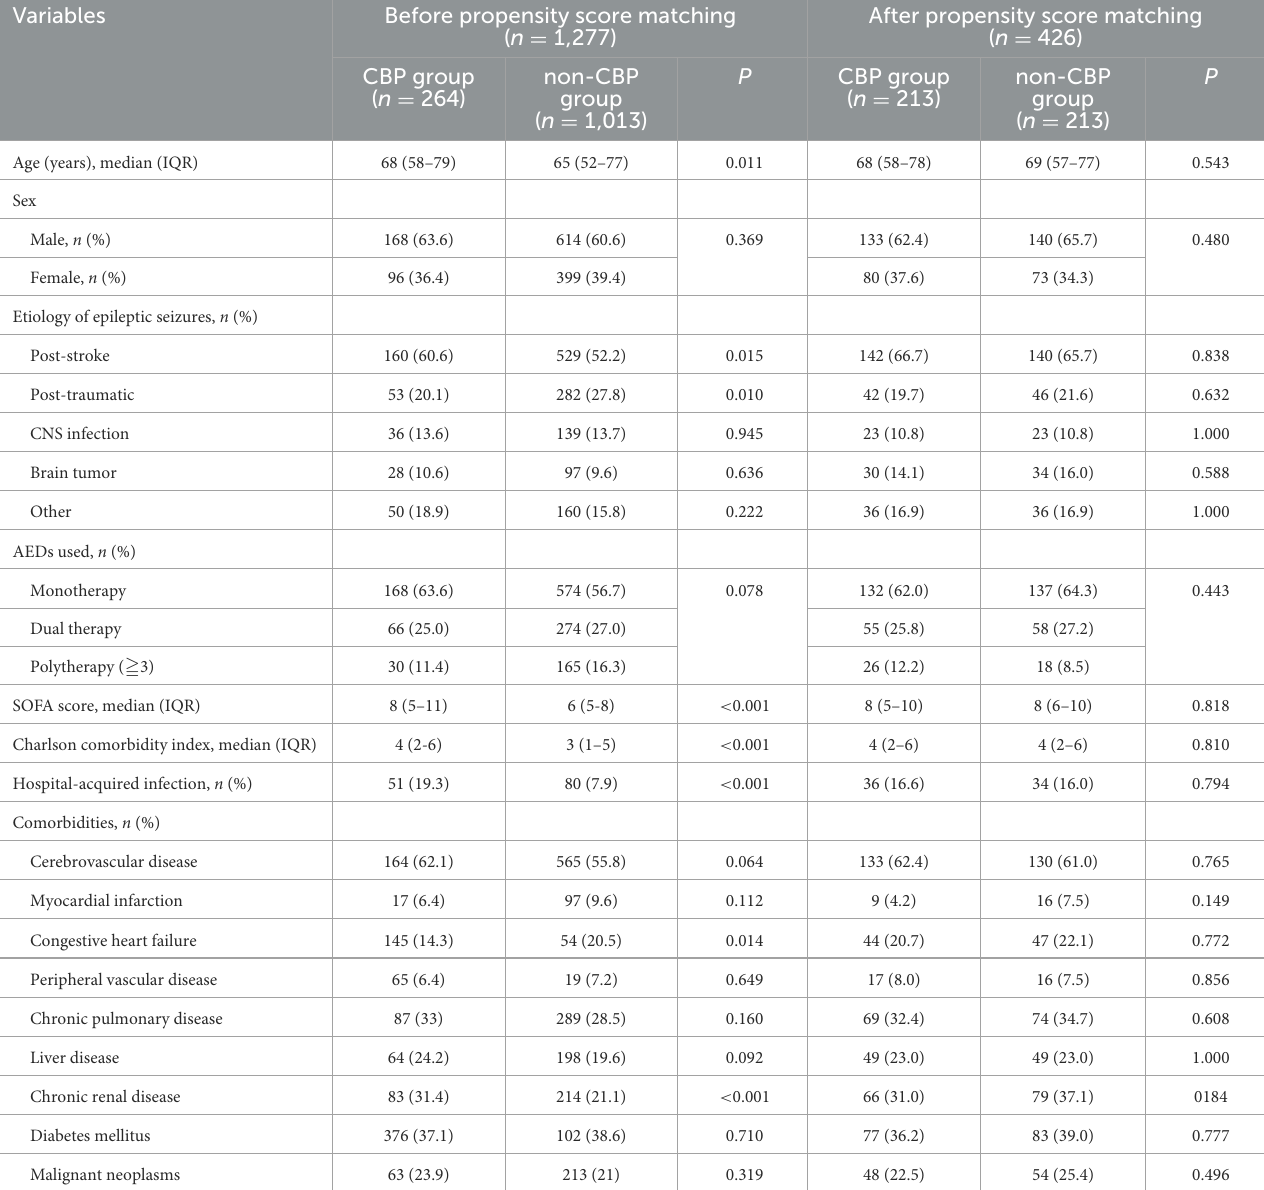
TABLE 2 Characteristics of VPA-treated patients with concomitant antibiotics use before and after propensity score matching.